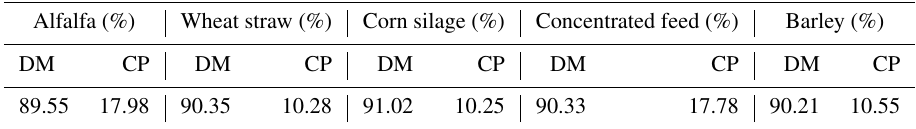
Table 1. Analysis results of feed given to ewes and rams. DM: dry matter. CP: crude protein. Alfalfa